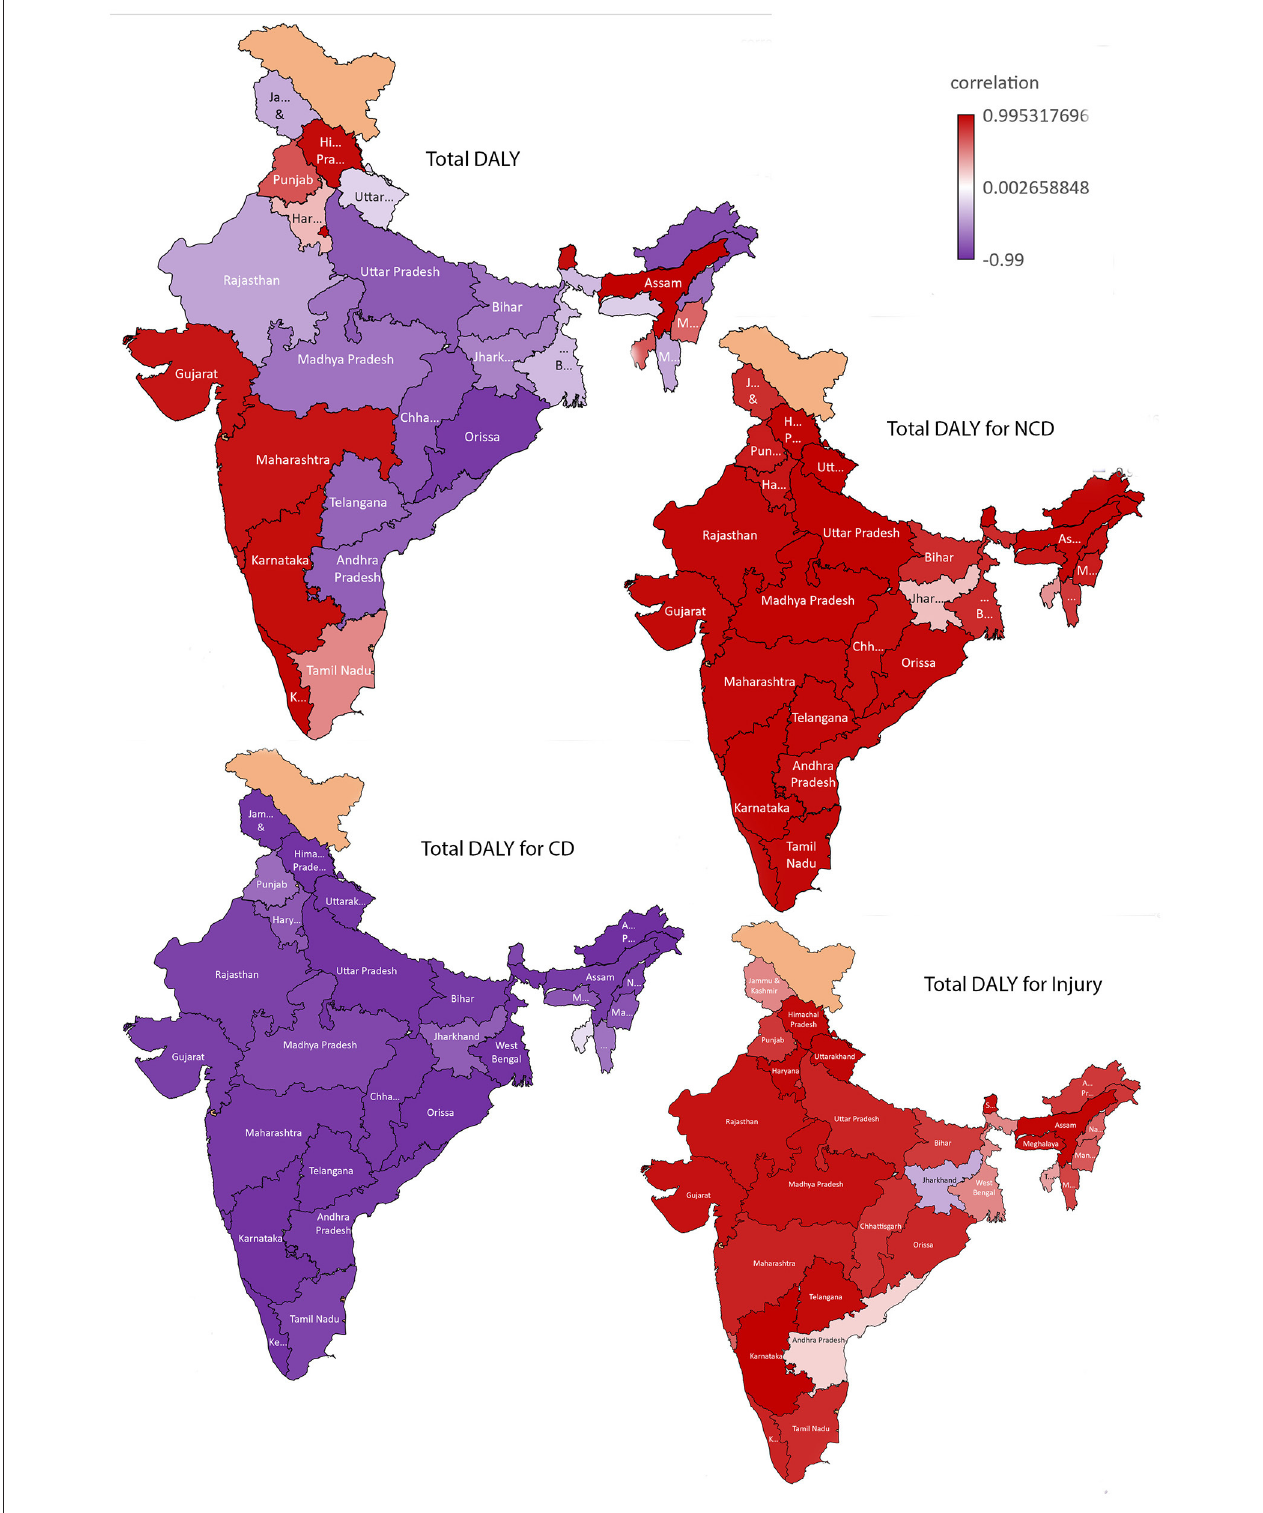
FIGURE 1 | Correlation between budget allocation and disease burden [(estimated as Disability Adjusted Life Years (DALY)] in India: for Total, Non-Communicable diseases (NCD), Communicable diseases (CD) and injuries.